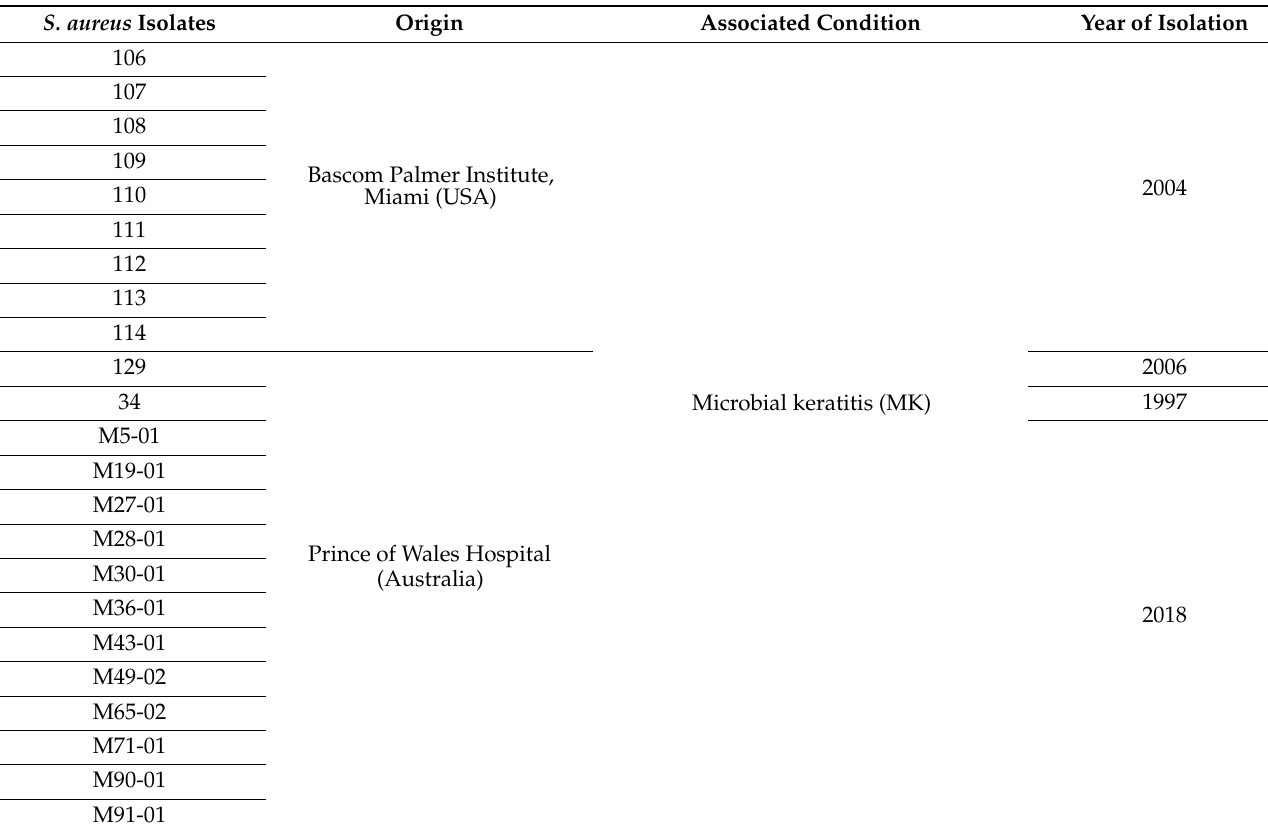
Table 4. S. aureus ocular isolates used in the